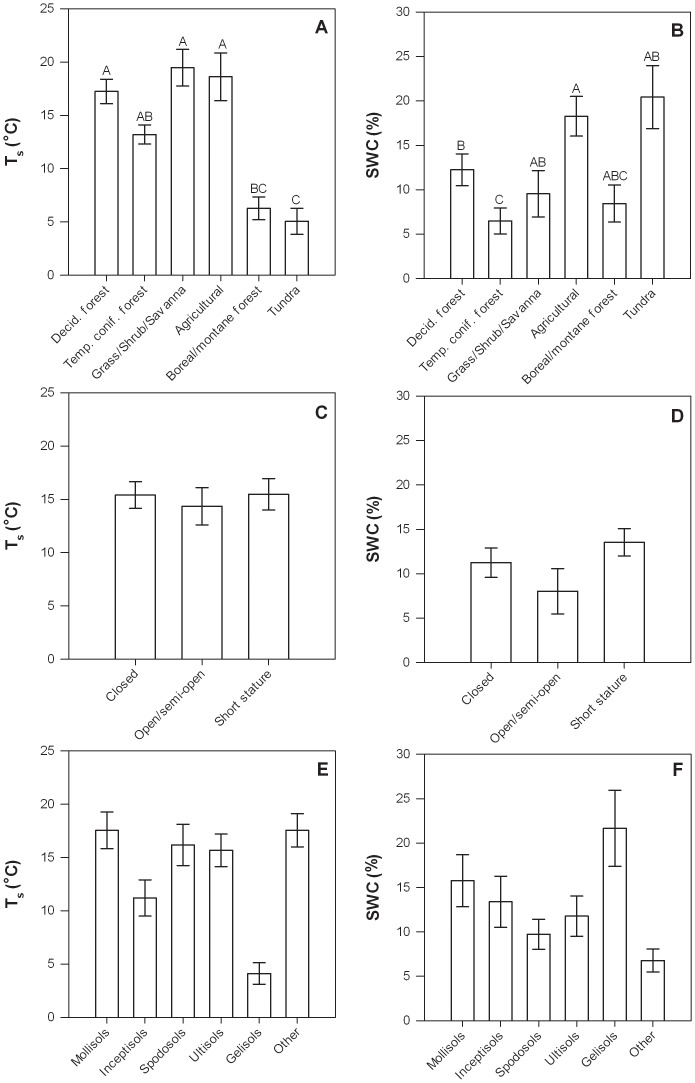
Mean Ts (left column) and SWC (right column) at each site in relation to ecosystem type (a, b), canopy structure (c, d), and soil type (e, f).Error bars represent ±1 SE. Bars with different letter were significantly different (p<0.05) based on Tukey HSD tests. The letter “A” corresponds to the largest least square mean(s) and subsequent letters (B, C, …) correspond to progressively smaller least square means.